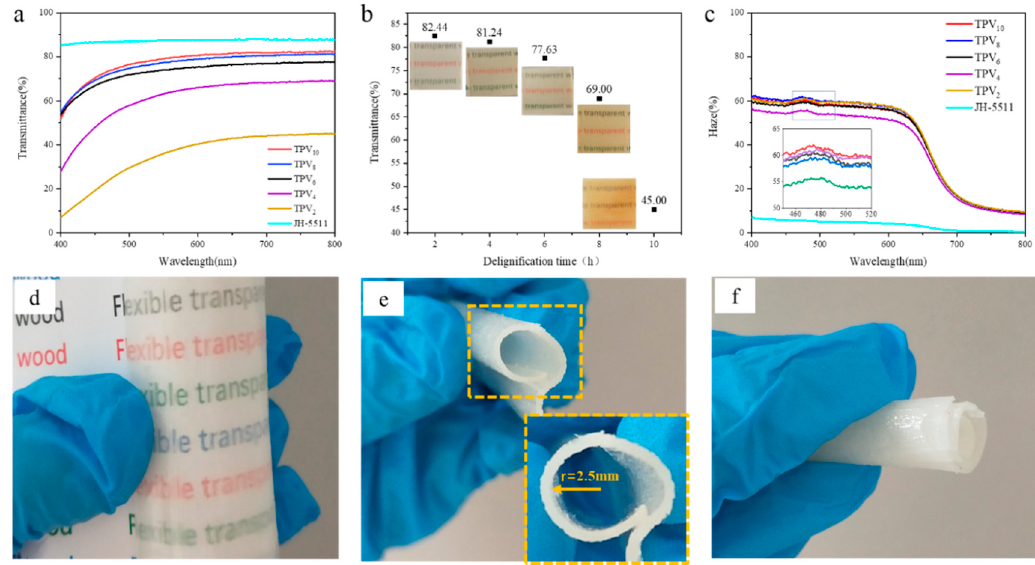
Figure 6. Optical properties and flexibility of TPVs. ( a ) Transmittance curves, ( b ) the actual light transmittance comparison chart at 800 nm, ( c ) haze curves, ( d ) optical performance of TPV 8 under bending, ( e ) the bending radius of TPV 8 , ( f ) curled diagram of TPV 8 .